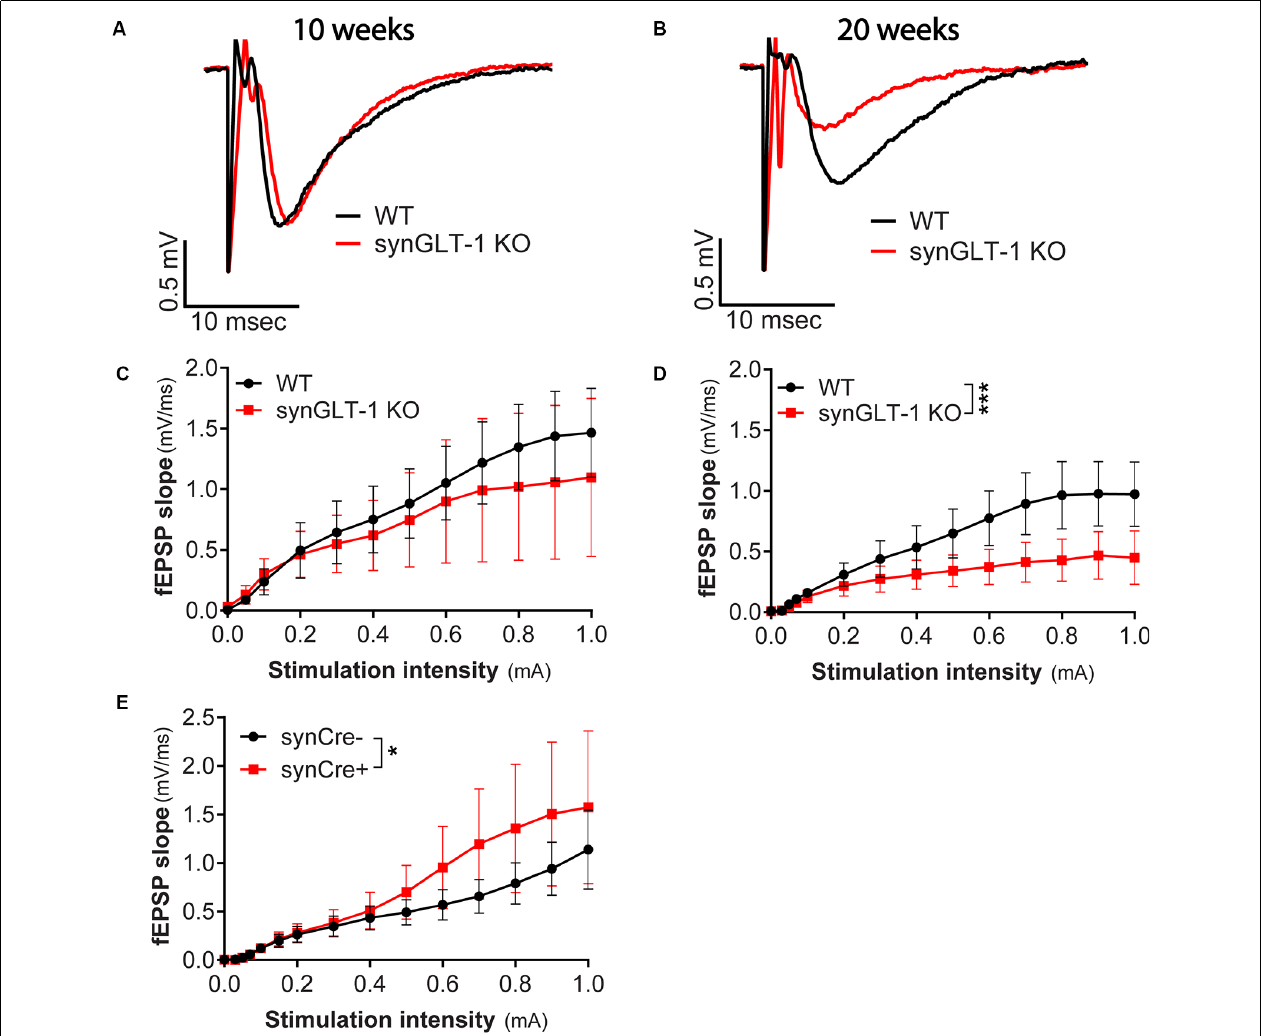
FIGURE 2 | Age-dependent impairment in excitatory synaptic transmission in synGLT-1 KO mice. (A,B) Representative fEPSPs recorded in the stratum radiatum of the CA1 region in hippocampal slices in response to a single electrical stimulus applied to the Schaeffer collateral/commissural fibers in 10 weeks (A) and 20 weeks old (B) WT littermate controls (black traces) and in synGLT-1 KO (red traces). fEPSP slope in 10 weeks old (C) and 20 weeks old (D) synGLT-1 KO produced by stimuli between 0 and 1 mA. (E) Cre-recombinase expression on a true wild-type background (GLT-1 +/+ ; 20 weeks) does not impair fEPSP generation. * = p < 0.05, *** = p < 0.001 in panels (D,E) indicate effect of genotype in a linear mixed